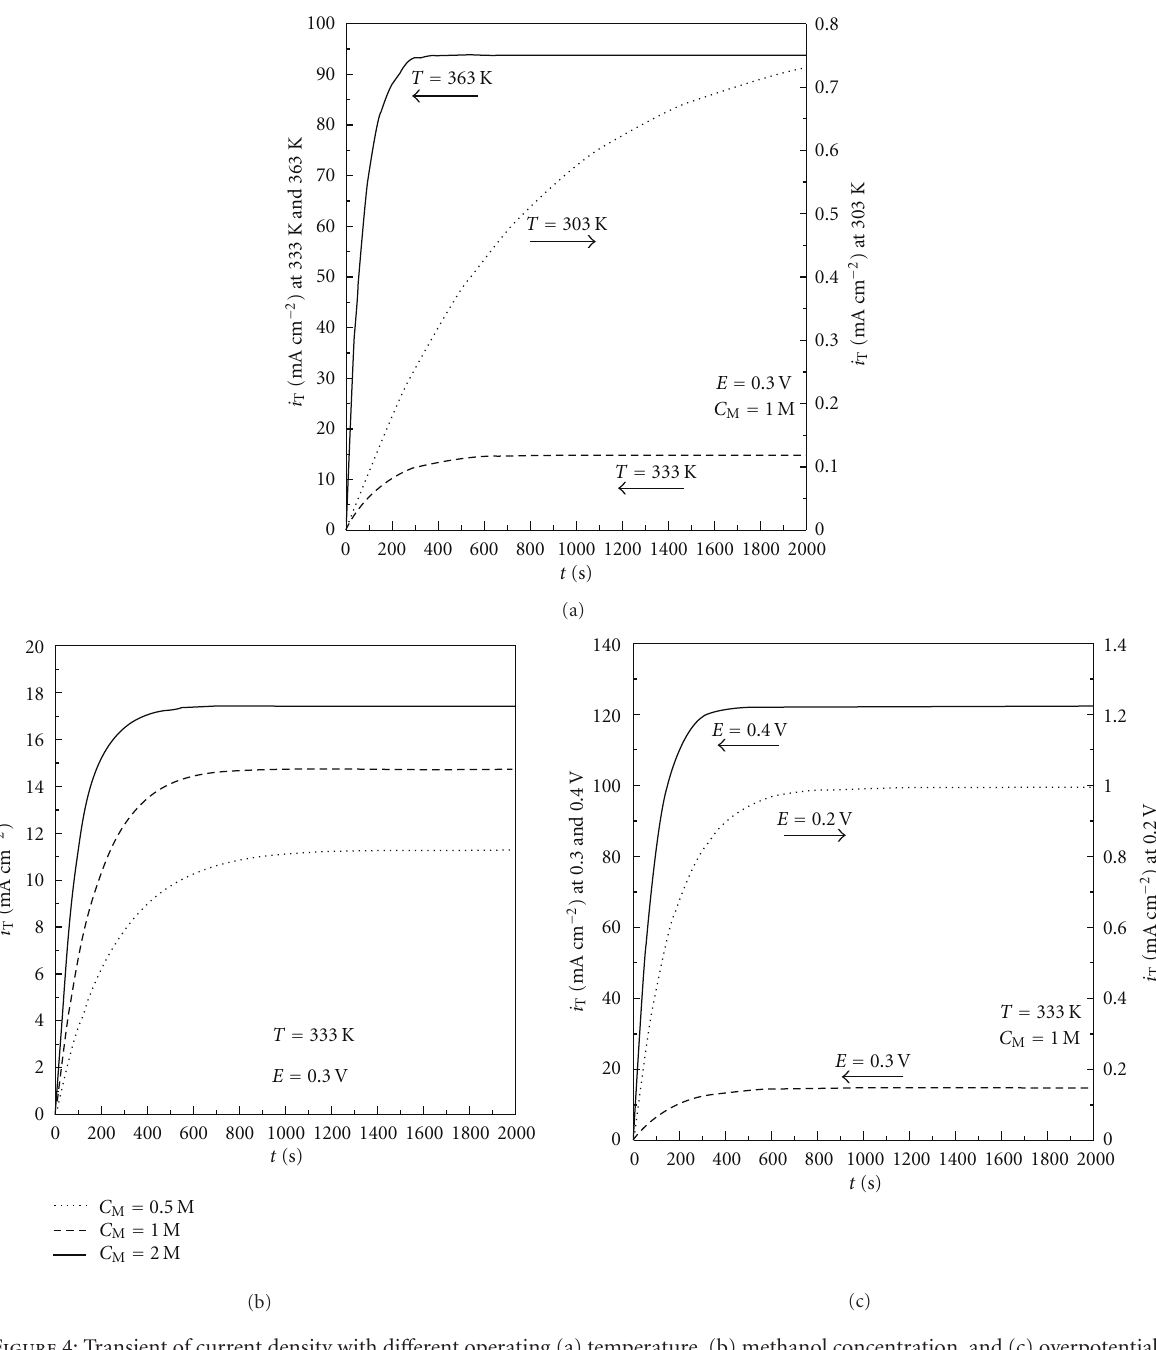
Figure 4: Transient of current density with di ff erent operating (a) temperature, (b) methanol concentration, and (c)